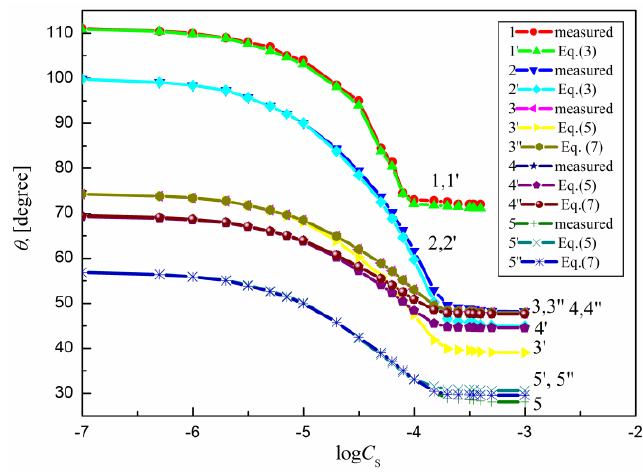
Figure 3. A plot of the contact angle ( ) of the aqueous solution of DM on the PTFE (curves 1 and 1′), PE (curves 2 and 2′), PMMA (curves 3, 3′ and 3′′), nylon 6 (curves 4, 4′ and 4′′) and quartz (curves 5, 5′ and 5′′) against the logarithm of DM concentration ( S C ). Curves 1–5—the measured values, curves 1′ and 2′—the values calculated from Equation (3), curves 3′, 4′ and 5′—the values calculated from Equation (5) and curves 3′′, 4′′ and 5′′—the values calculated from Equation (7).